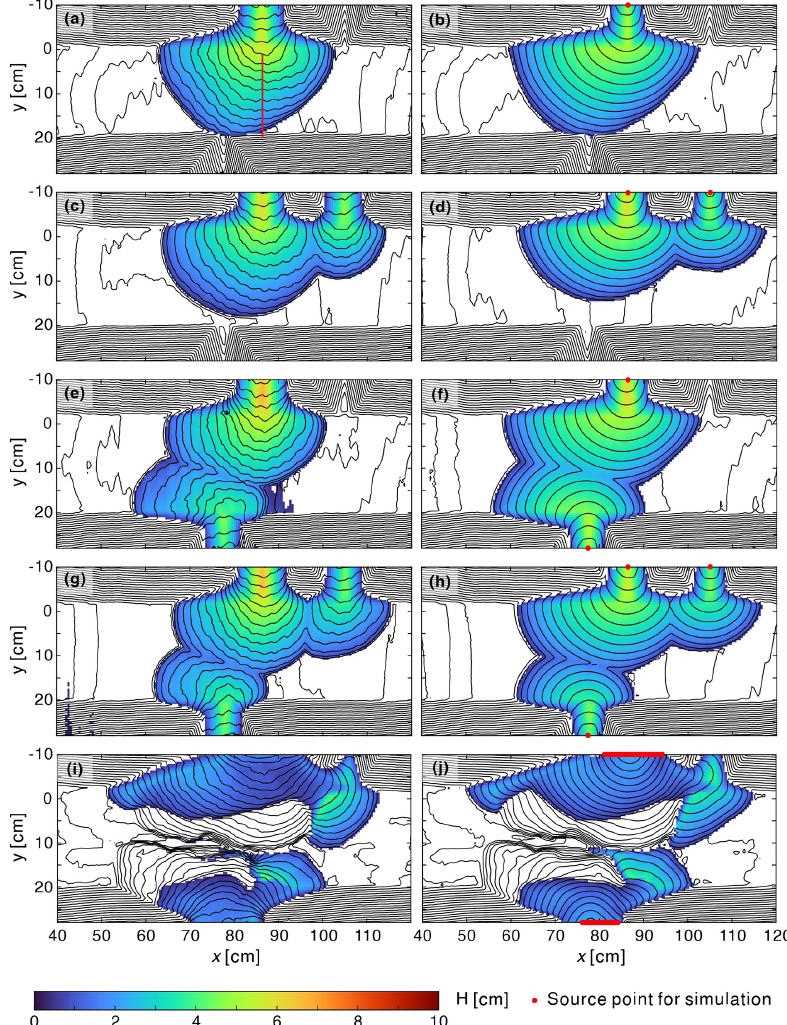
Figure 11. Comparison of measured (left) and simulated (right) deposit topographies for the canyon–valley experiments: (a,b) run T11, (c,d) run T12, (e,f) run T13, (g,h) run T14, and (i,j) run T15. Lines show the elevation contours at intervals of (cid:49)z = 0 .